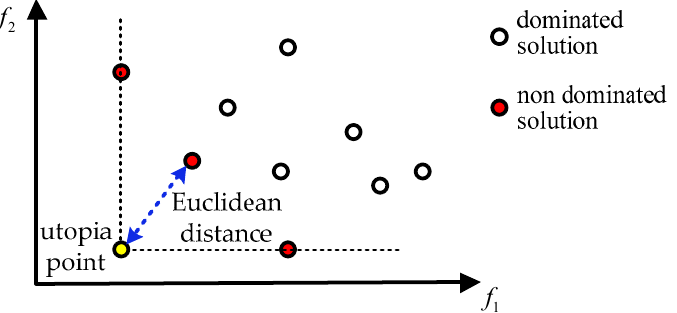
Figure 1. Illustration of the multi-objective problem. The red dots form the Pareto front, the yellow dot denotes the utopia point, and the blue dashed line stands for the shortest Euclidean distance.